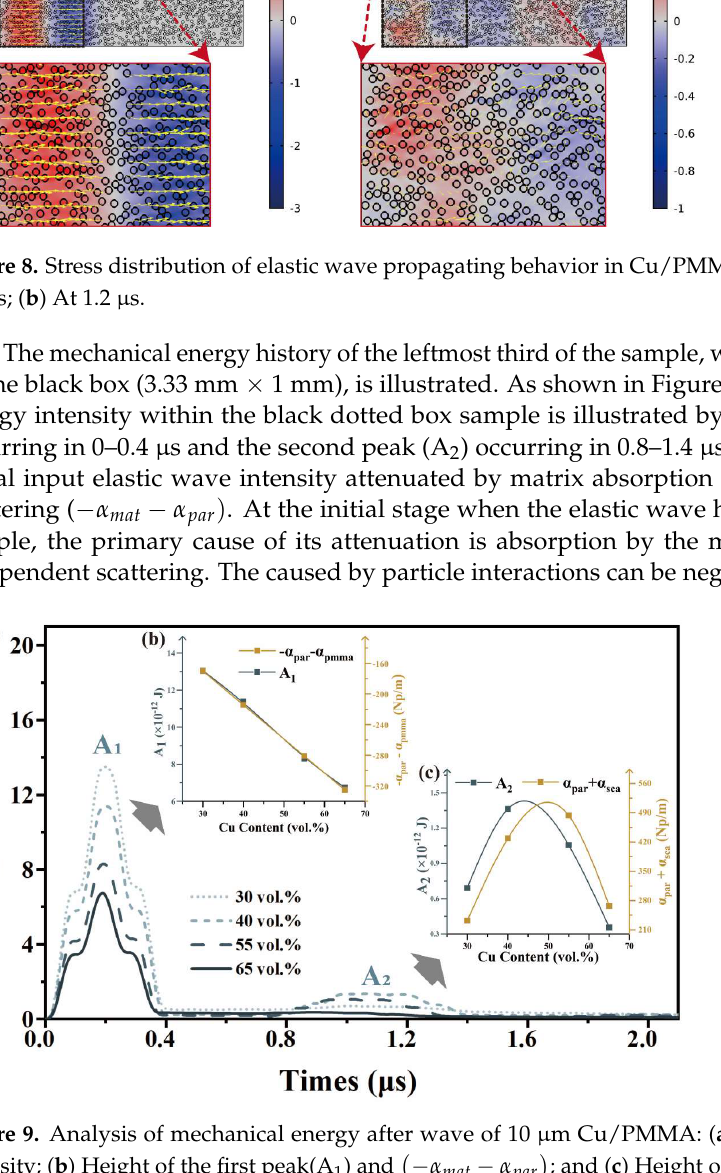
(cid:0) − (cid:1) α mat − α par ; and ( c ) Height of the second peak(A 2 )